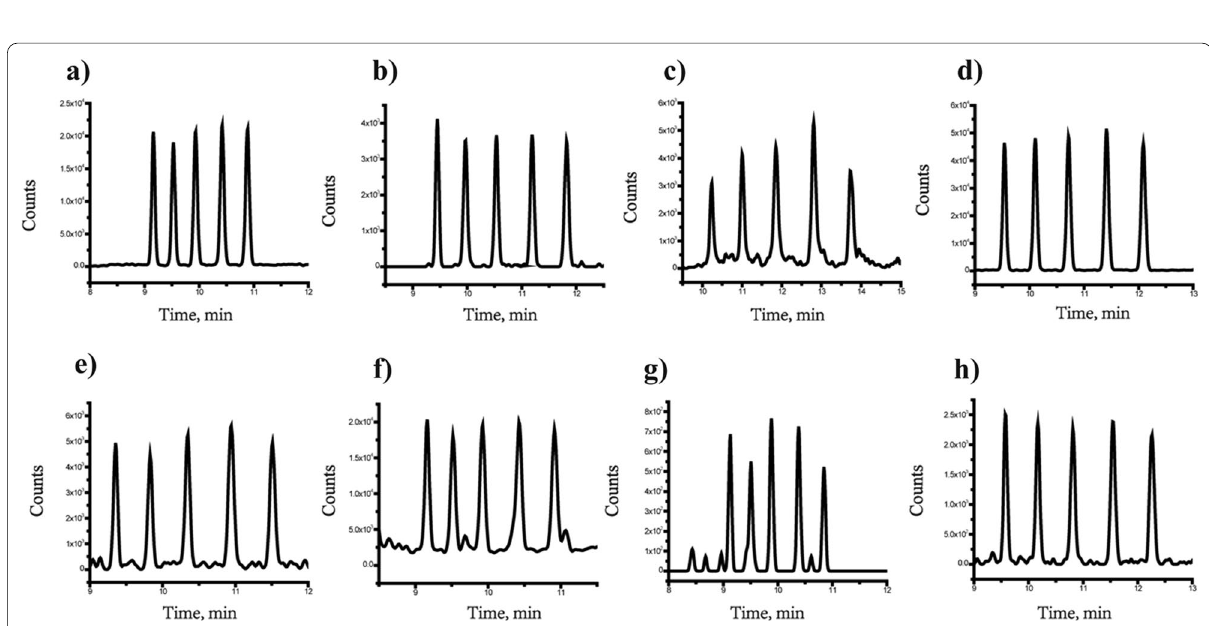
Fig. 7 Extracted ion chromatograms obtained from CE-MS analysis of Ser ( a ), Met ( b ), GSH ( c ), Glu ( d ), Asn ( e ), Val ( f ), Cystathionine ( g ), Cystine ( h ) in multi-segment injection